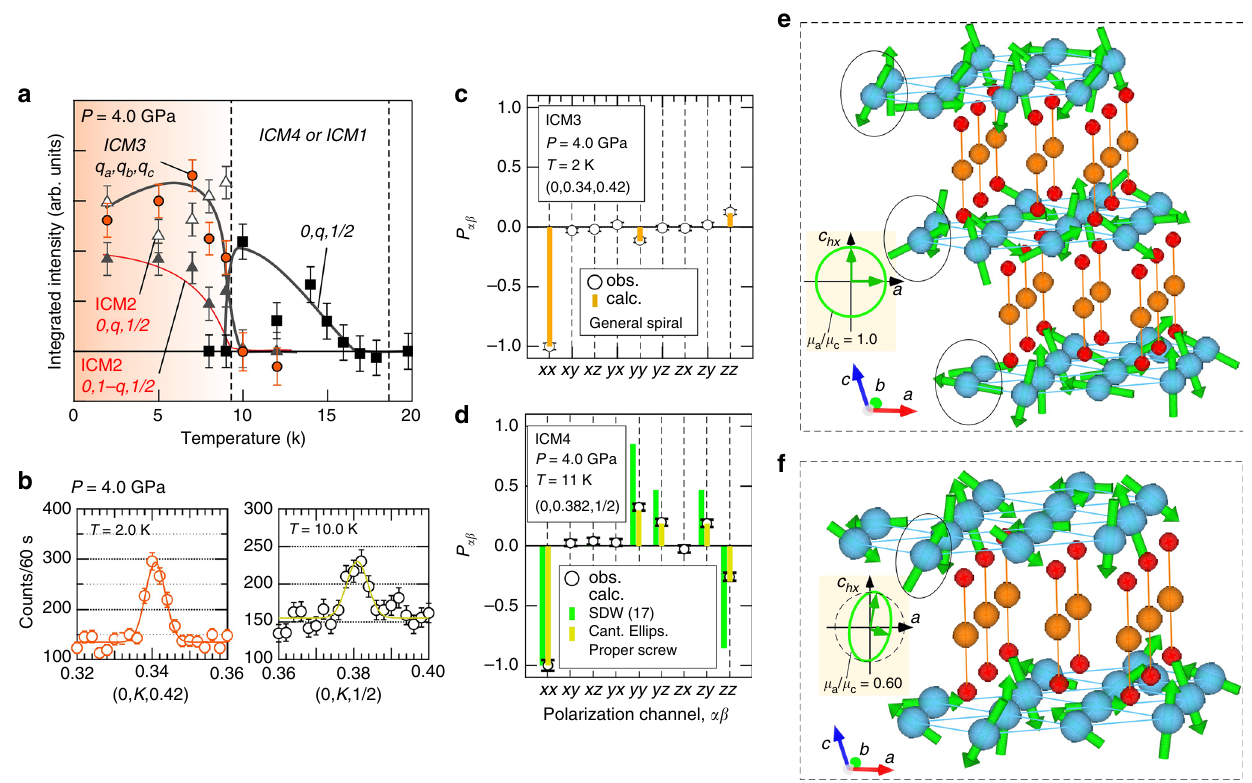
Fig. 4 Spherical neutron polarimetry data at 4.0 GPa. a Temperature dependence of the integrated intensities of magnetic re fl ections and b typical diffraction pro fi les along the [0, K , 0.42] line for the ICM3 phase and the [0, K , 1/2] line for the ICM4 phase with the spin fl ip channel in the x -direction at P = 4.0 GPa. Note that the phase boundary between ICM1 and ICM4 phase at 4.0 GPa is not clear due to the sample propagation vector k = (0, q , 1/2), as indicated by ICM4 or ICM1. Comparisons between observed and calculated polarization matrix elements: c the 0, 0.34, 0.42 re fl ection at T = 2 K in the ICM3 phase and d the 0, 0.382, 1/2 re fl ection at T = 11 K in the ICM4 phase at P = 4.0 GPa, with values calculated based on SDW, using spins canted by 17° and a canted ellipsoidal proper screw model. The determined magnetic structures: e the general spiral structure with both cycloid modulation along the c -axis and proper screw modulation along the b -axis, and f the canted ellipsoidal proper screw with spins con fi ned to the ac-plane, the major ellipsoidal axis canted by 5 ± 1°, and the ellipsoidal ratio | B |/| A | = 0.60 ±